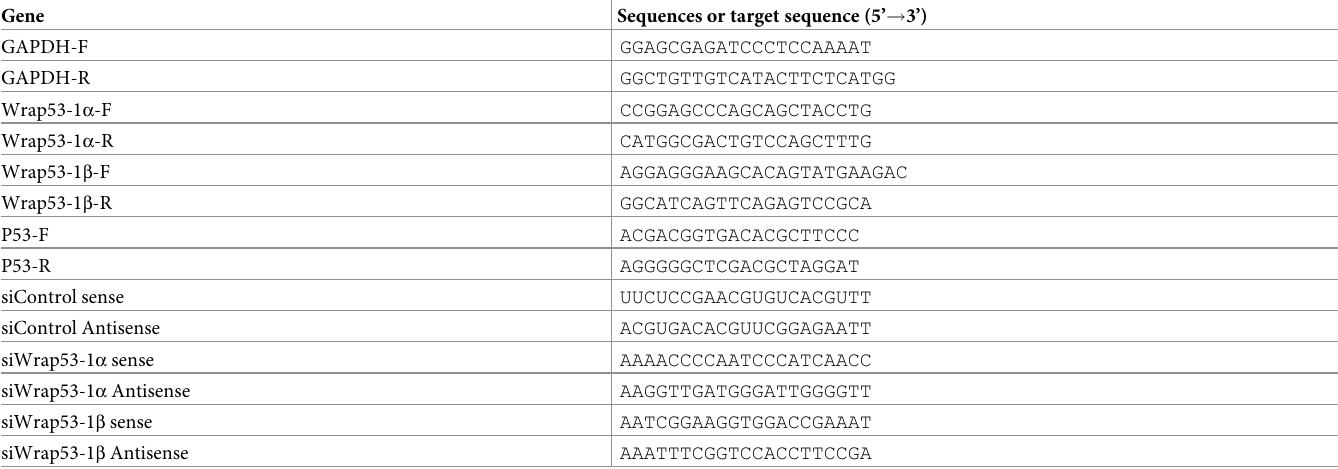
Table 1. Primer sequences and siRNA sequences used in this